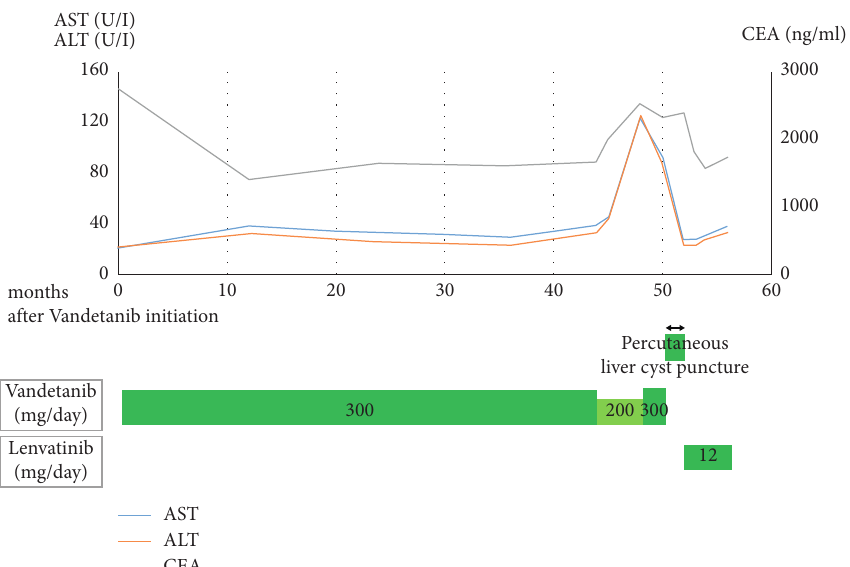
Figure 3: Clinical course and blood examination. AST: aspartate aminotransferase, ALT: alanine aminotransferase, and CEA: carci- noembryonic antigen.